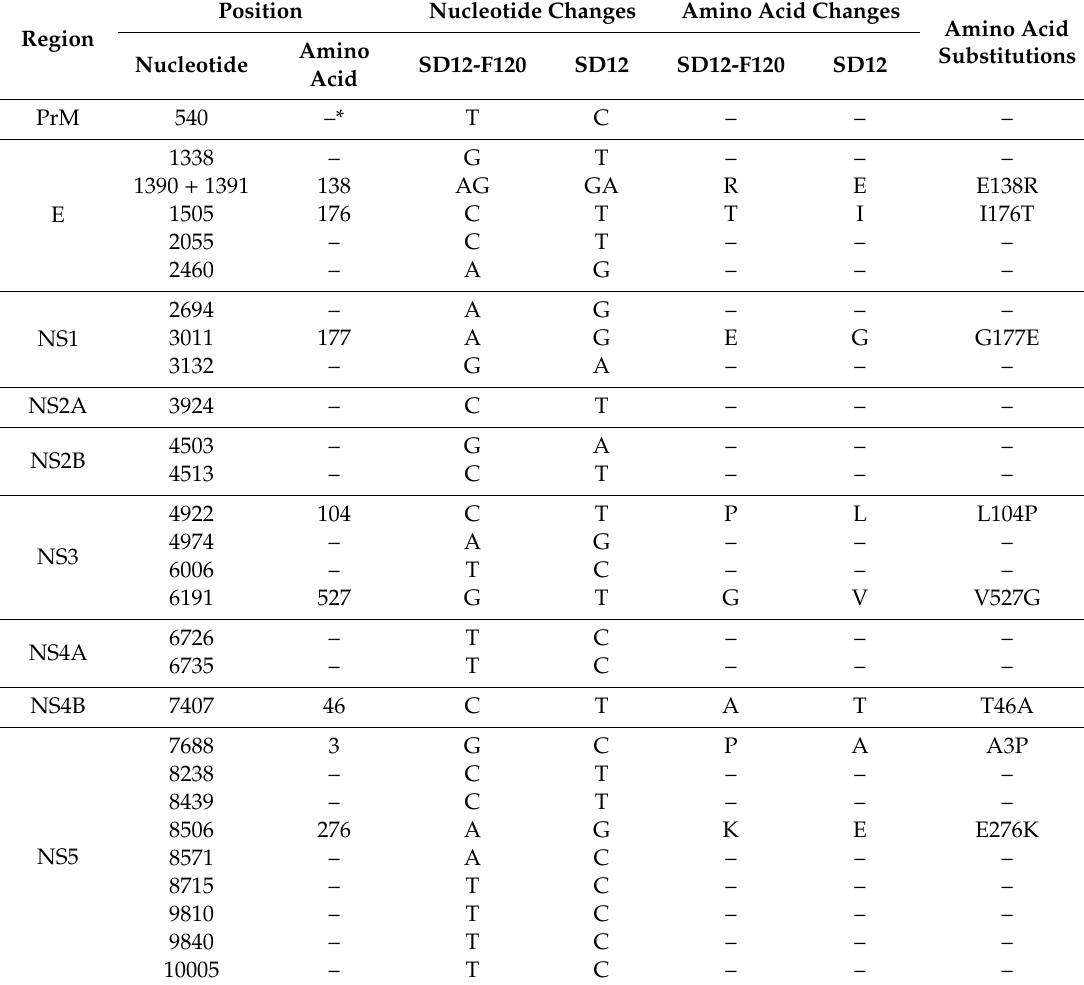
Table 1. Nucleotide and amino acid variations between SD12-F120 and SD12.